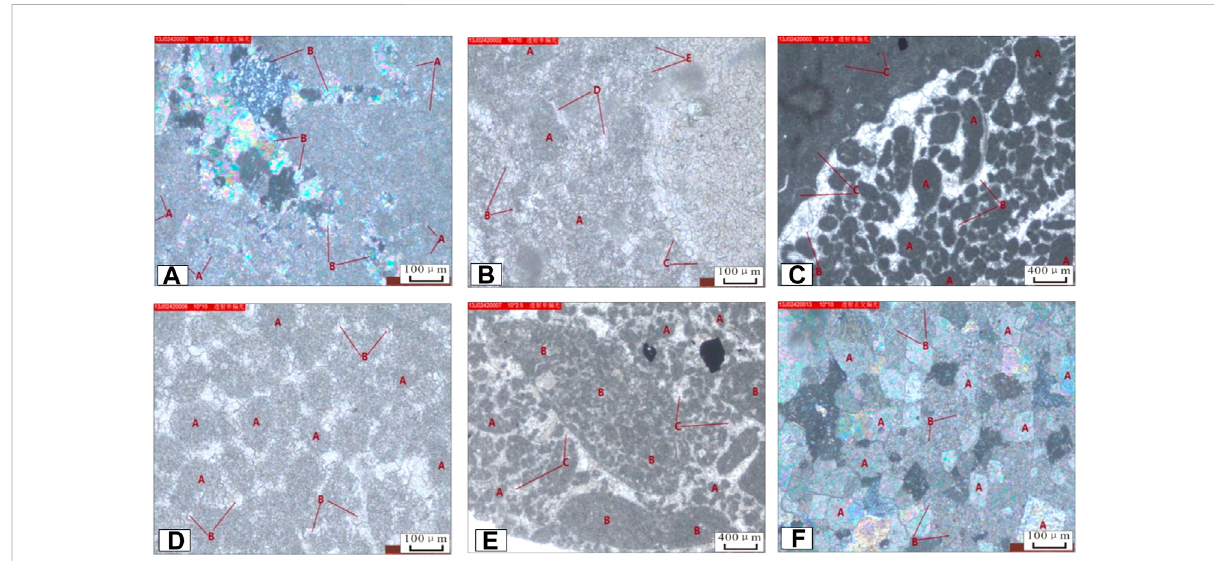
FIGURE 3 Petrological characteristics of carbonates from the Ordovician Yingshan Formation. (A) : T43-1 depth of 5280 m, O1-2y, microcrystalline limestone, orthogonally-polarized transmission 10*10. A: microcrystalline calcite, B: recrystallized calcite; (B) : T43-1, depth of 5285 m, O1-2y, fi ne- grainedcalcarenite,single-polarizedtransmission,10**10.A:sandchip,B:powderedcalcite,C:microcrystallinecalcite,D:sparrycalcite,E:powdery crumbs; (C) : 542, depth of 5289 m, O1-2y, micritic sparry calcarenite, single-polarized transmission, 10*2.5. A: sand chip, B: sparry calcite, C: argillaceous calcite ; (D) : T42-1, depth of 5273 m, O1-2y, sparry calcarenite, single-polarized transmission, 10*10. A: sand chip, B: sparry calcite; (E) : T44, depth of 5269 m, O1-2y, sparry calcirudite, single-polarized transmission, 10*2.5. A: sand chip, B: gravelly debris, C: sparry calcite; (F) : T8-5, depth of 6175 m, O1-2y, fi ne-grained dolomite with intense dolomitization, orthogonally-polarized transmission, 10*10. A: dolomite, B: